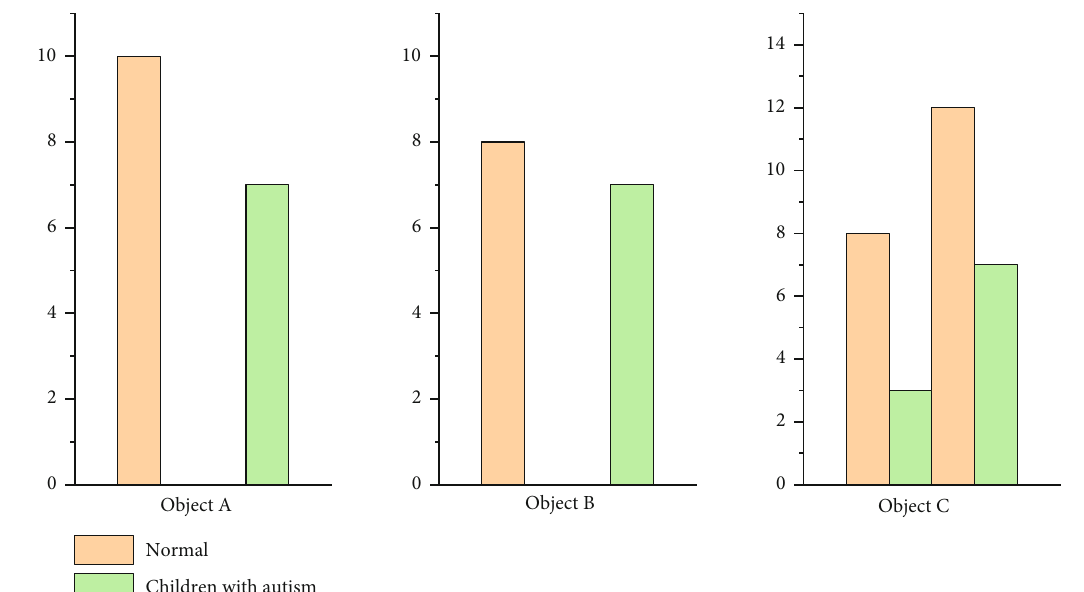
Figure 3: Action imitation result statistics.